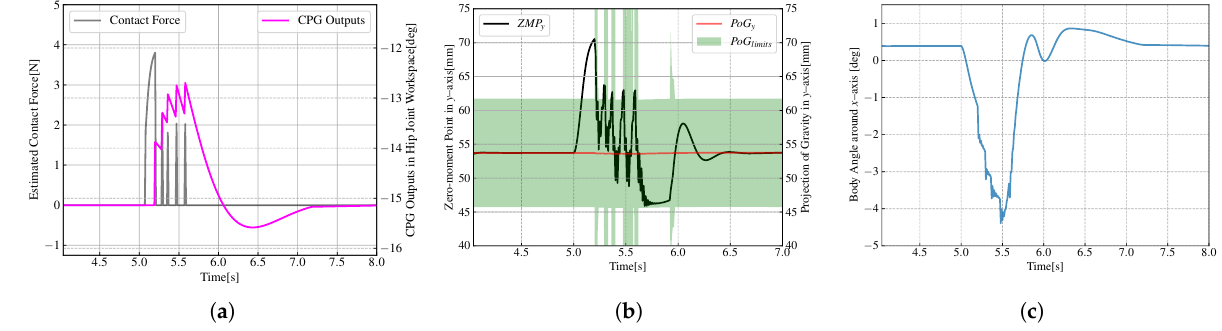
Figure 10. Variations of variables when the robots standing on a single foot with CPG. ( a ) Variations of contact force and CPG output. ( b ) Variations of ZMP, the estimated projection of gravity (PoG) and the limit of PoG. ( c ) Variations of body